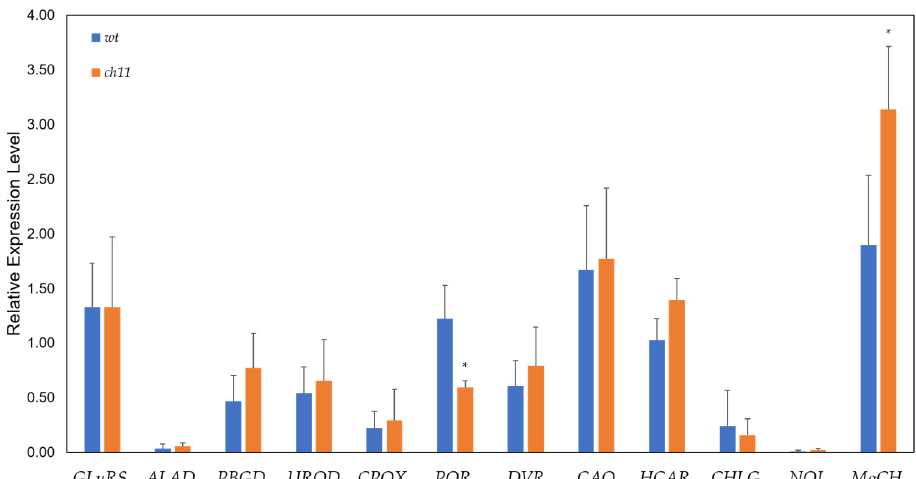
Figure 7. Expression of levels of 12 differentially expressed genes from wild-type ( wt ) and chlorophyll b -deficient ( ch11 ) rice. Gene expression was measured using quantitative RT-qPCR. Asterisks (*) indicate significant differences between the expression levels of the wild-type and ch11 rice ( p ≤ 0.05).